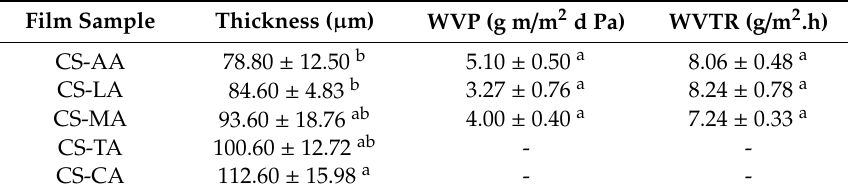
Table 2. Physicochemical properties of shrimp chitosan